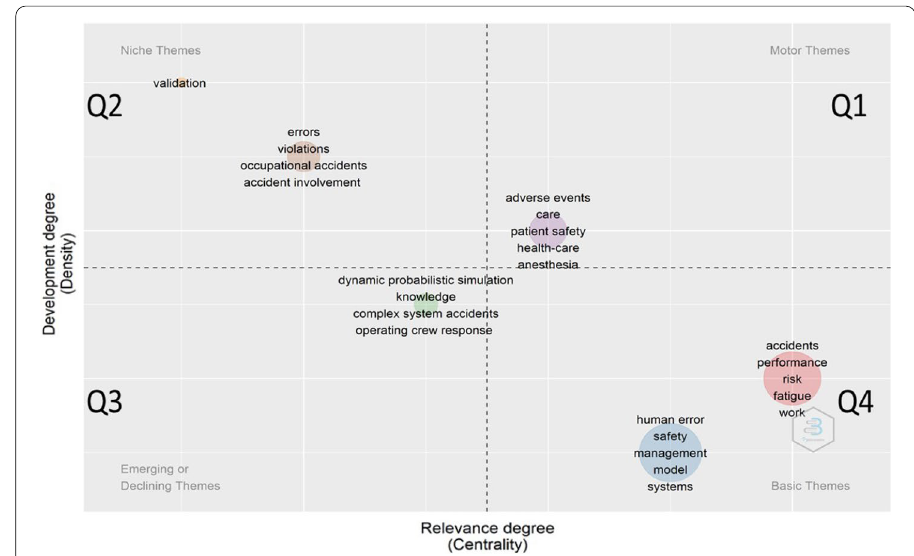
Fig. 6 Thematic map with co‑occurrence of keywords for “Human error